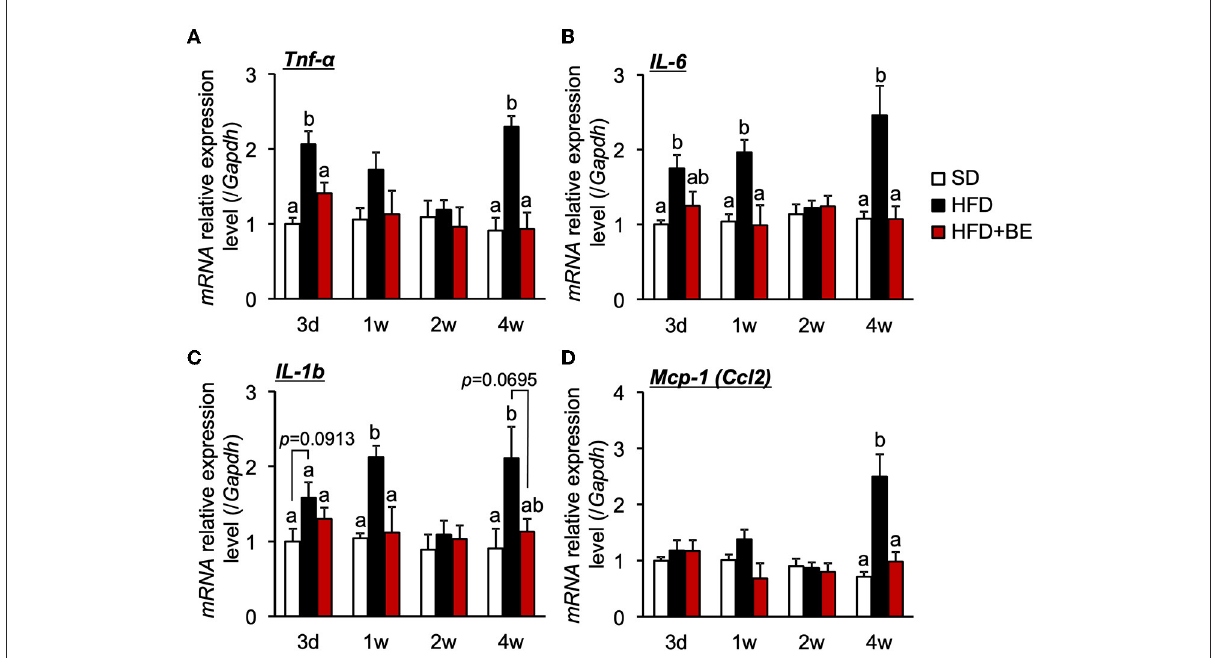
FIGURE2 Effects of and HFD and BE on hypothalamic pro-inflammatory cytokine and chemokine gene expression. Quantitative RT-PCR analysis, showing high expression of genes encoding pro-inflammatory cytokines (A) Tnf- α , (B) Il-6 , (C) Il-1b and a chemokine (D) Mcp-1 in the whole hypothalamus of mice on Day 3 (3d), Week 1 (1w), Week 2 (2w), and Week 4 (4w) of the feedings. Data shown are mean ± SE ( n = 5). Different letters represent significant differences among the three groups at each experimental period by Tukey-Kramer honestly significant difference test ( p <